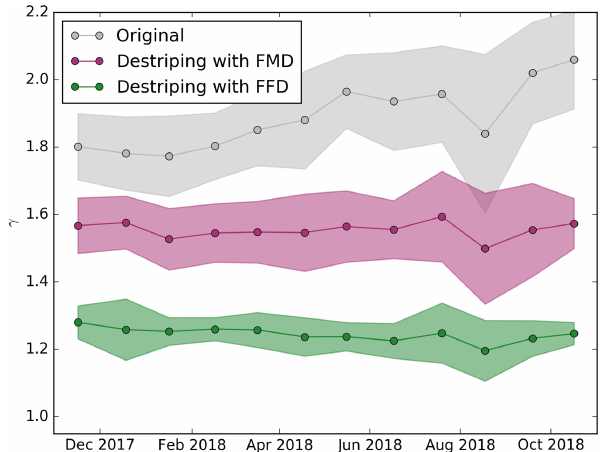
Figure 10. The stripiness measure γ as defined in Eq. (7) as a func- tion of time: (gray) original data, (pink) destriping with the FMD approach and (green) destriping with the FFD approach. Monthly medians are shown and the shaded area indicates an estimate of the noise (median ± 84th